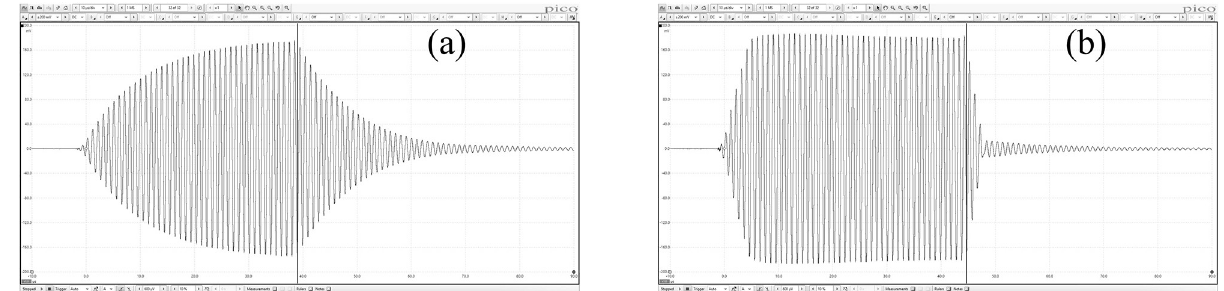
Fig 7. Measured actual pulses of (a) square pulse input and (b) compensated square pulse input. Vertical solid lines indicate the input pulse ends.